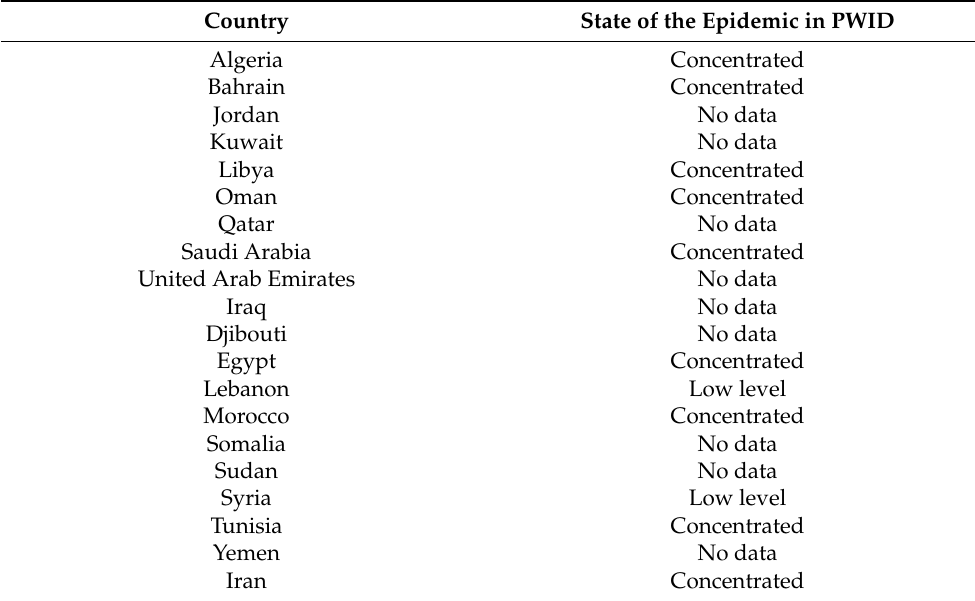
Table 3. State of epidemic in PWID within MENA countries